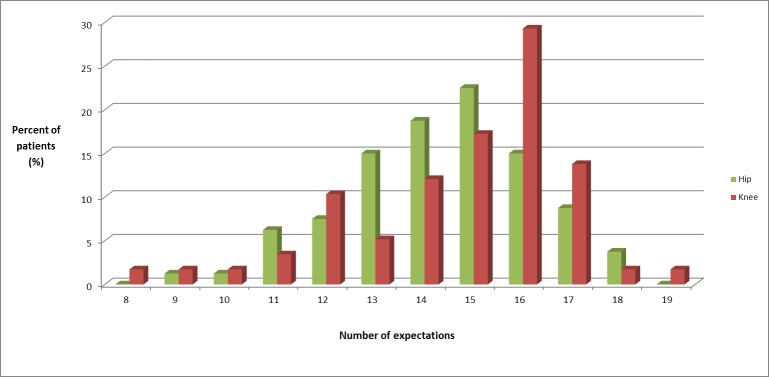
Number of expectations.Percentage of patients expressing each number of expectations from the 18-item/19-item Hospital for Special Surgery Total Hip/Knee Replacement Expectations Survey.